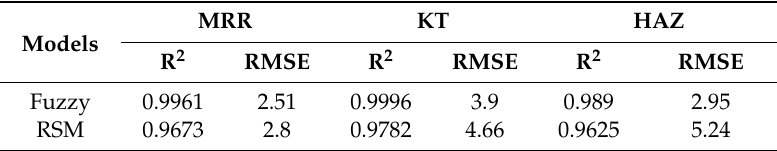
Table 4. Comparison of fuzzy and RSM